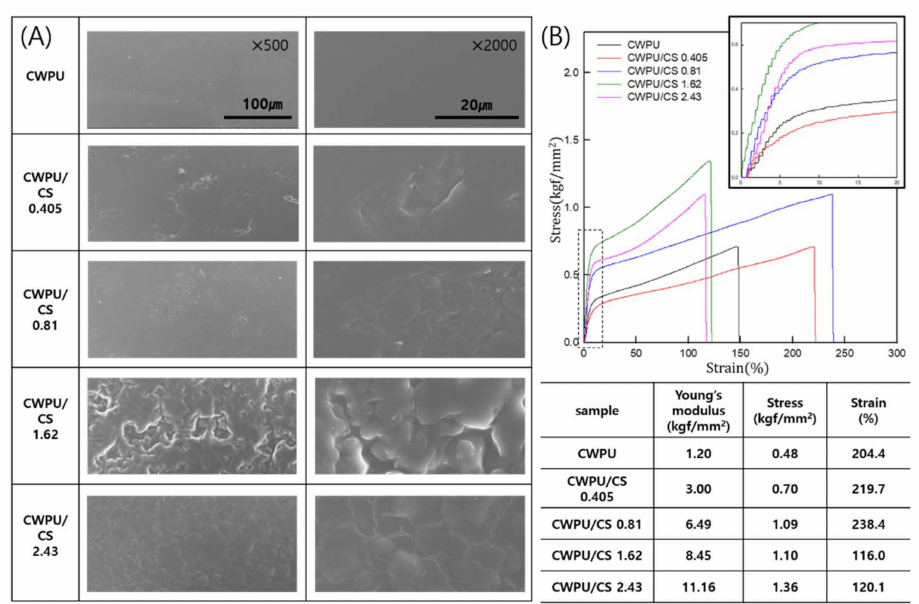
Figure 5. ( A ) SEM images and ( B ) Stress-Strain curves of CWPU and CWPU/CS nanocomposites with various CS contents (n ≥